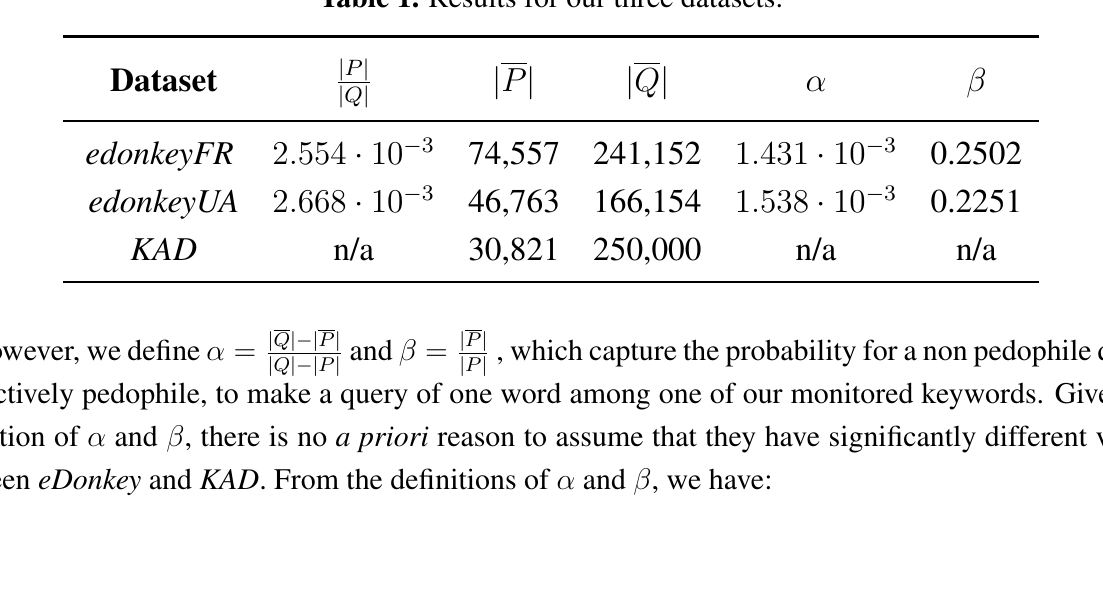
Table 1. Results for our three